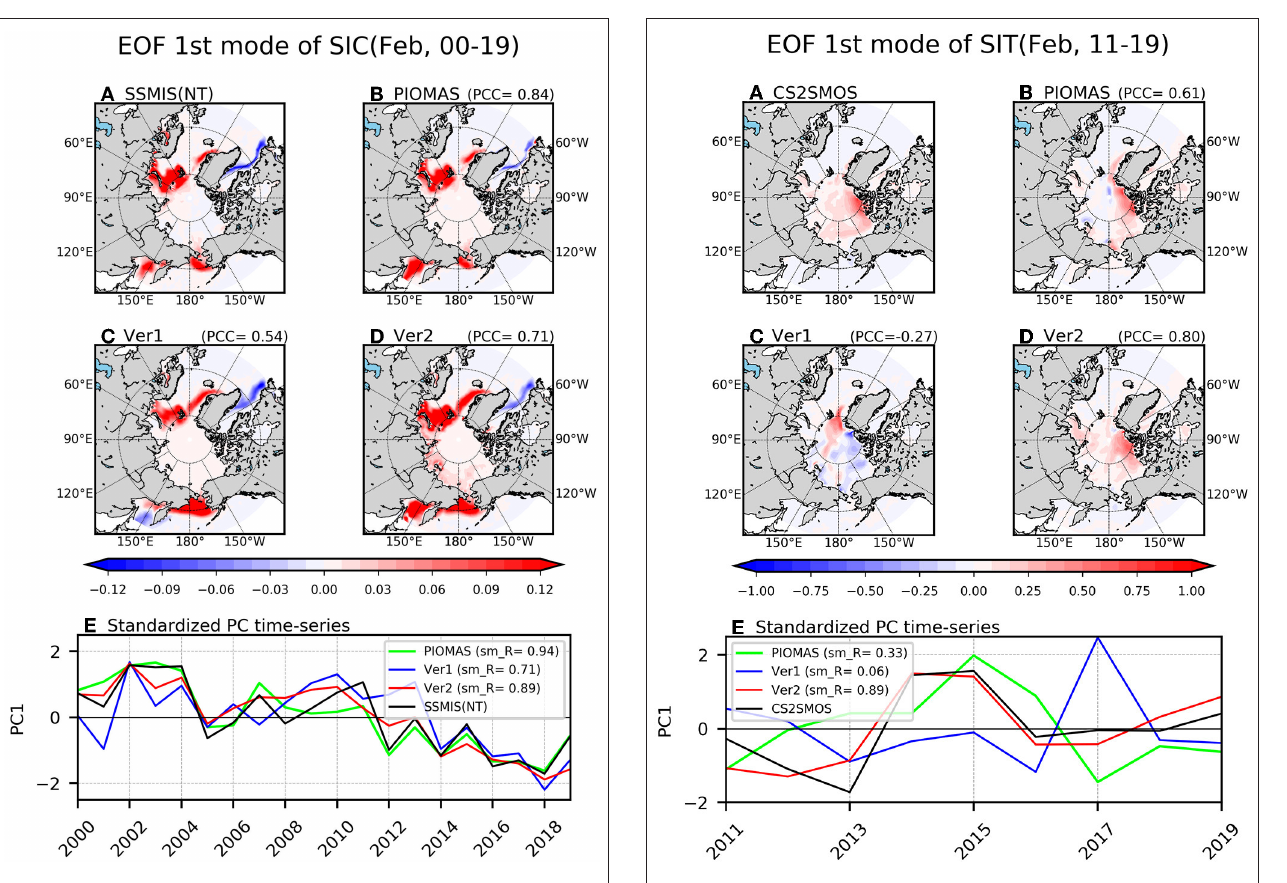
FIGURE 14 | The first EOF mode of sea ice thickness in February during the period 2011 − 2019. The CS2SMOS satellite thickness data is used here. The arrangement of the plots is the same as in Figure 13